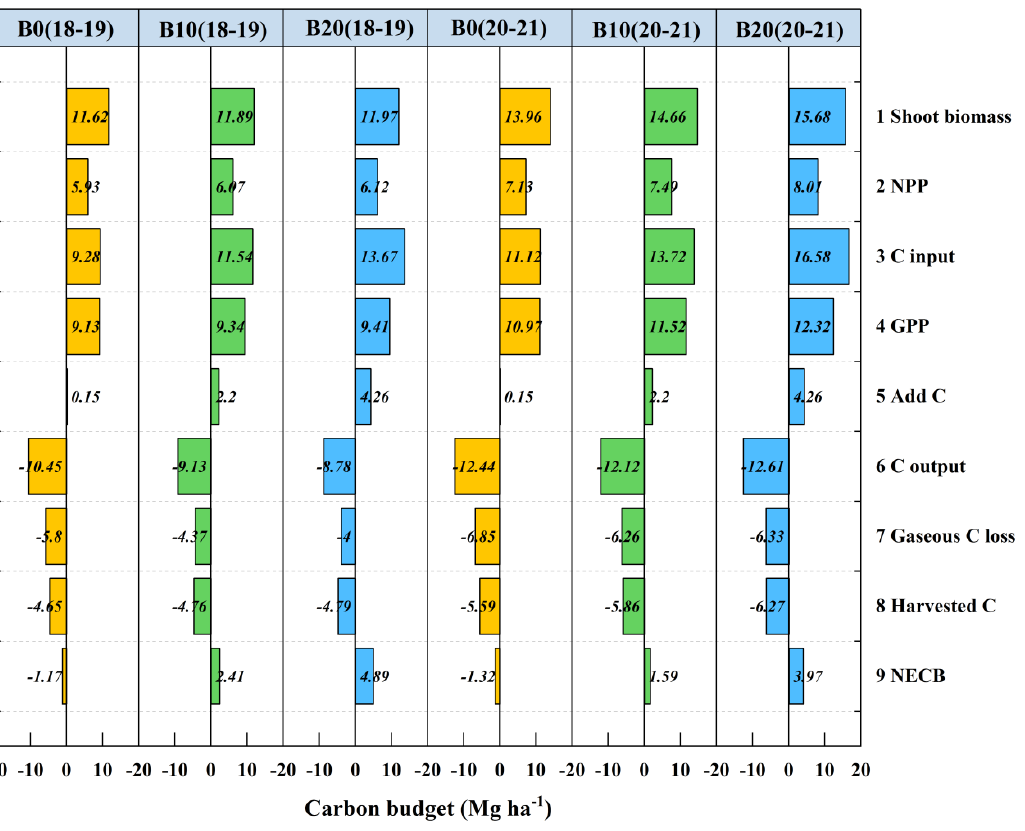
Figure 10. Characteristics of net ecosystem carbon budget in winter wheat fields under different amounts of added biochar in 2018–2019 and 2020–2021. Note: NPP represents net primary production, GPP represents gross primary production, and NECB represents net ecosystem carbon budget.